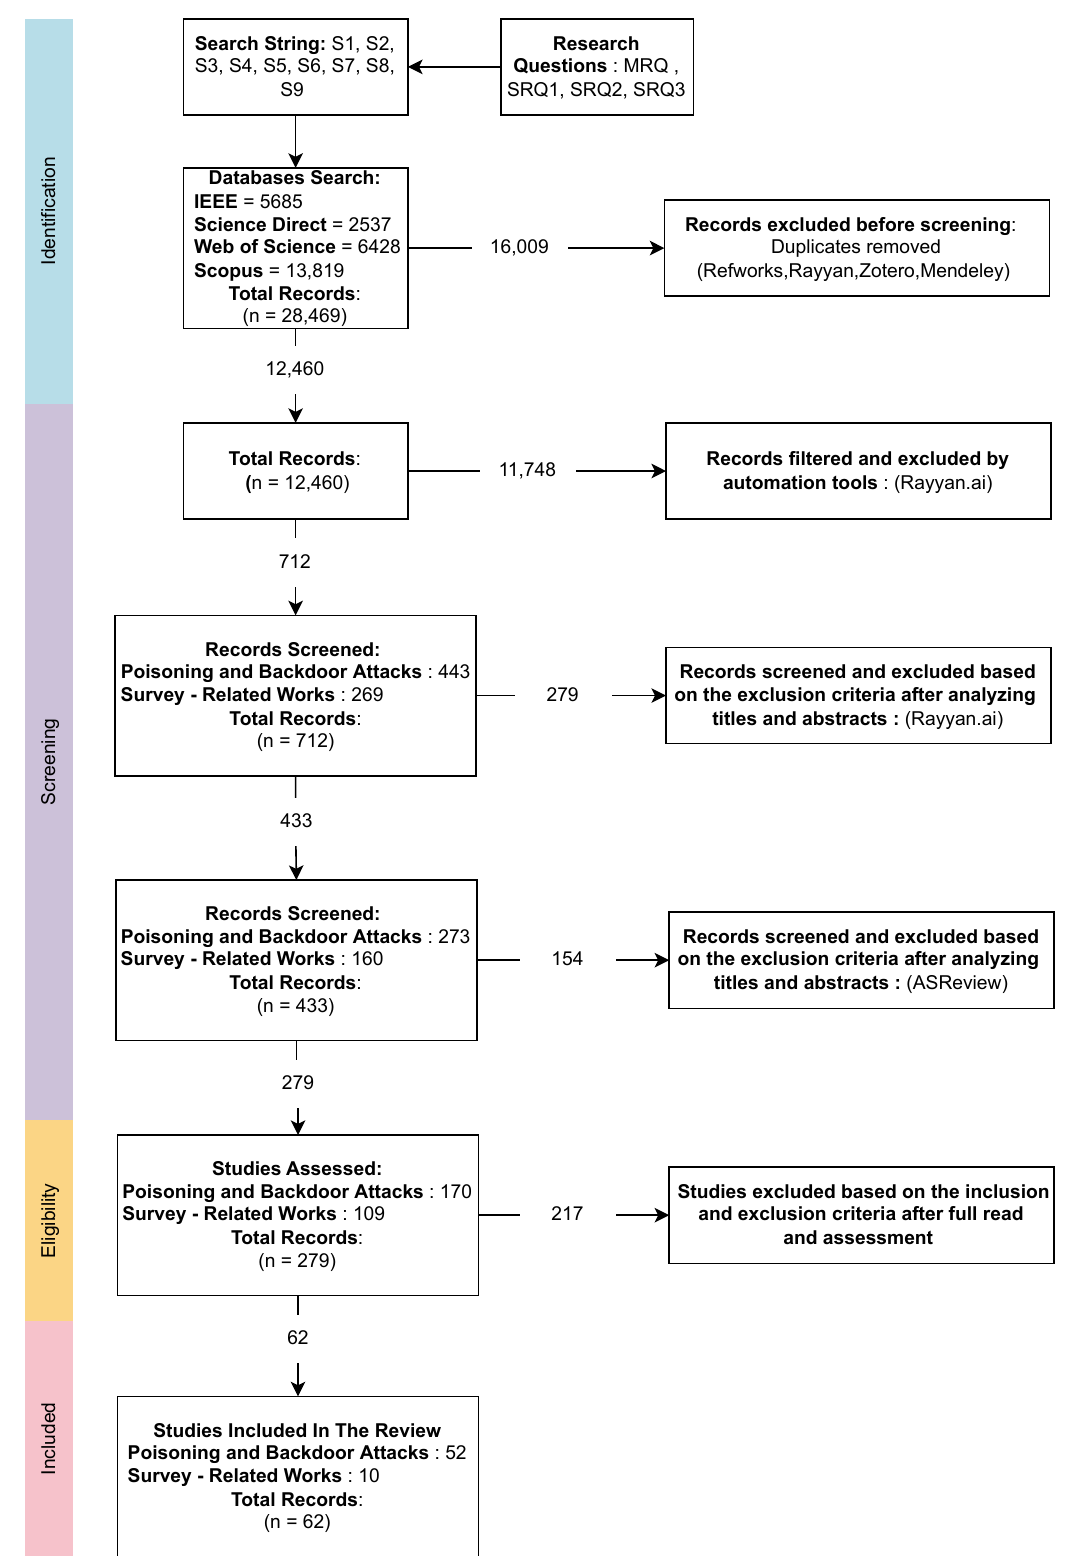
Figure 5. Research process for paper